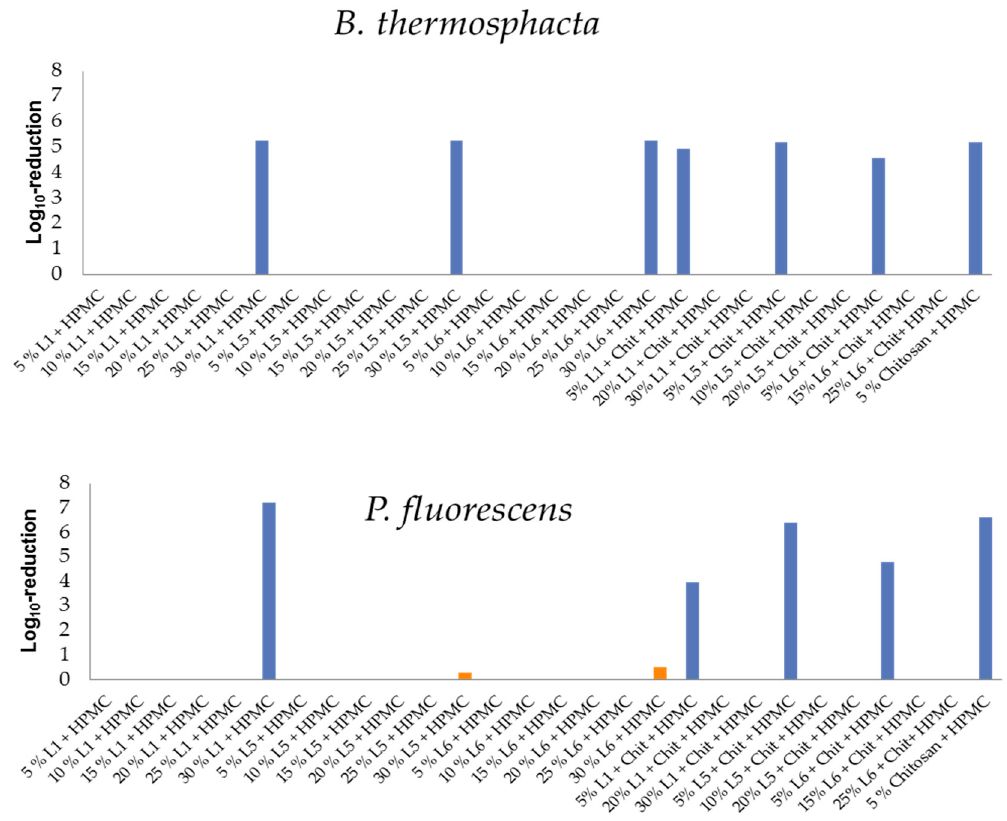
Figure 7. Antimicrobial activity of HMPC / lignin and HPMC / lignin / chitosan films against B. thermosphacta (above) and P. fluorescens (below). Columns in orange relate to nonactive films against P. fluorescens .